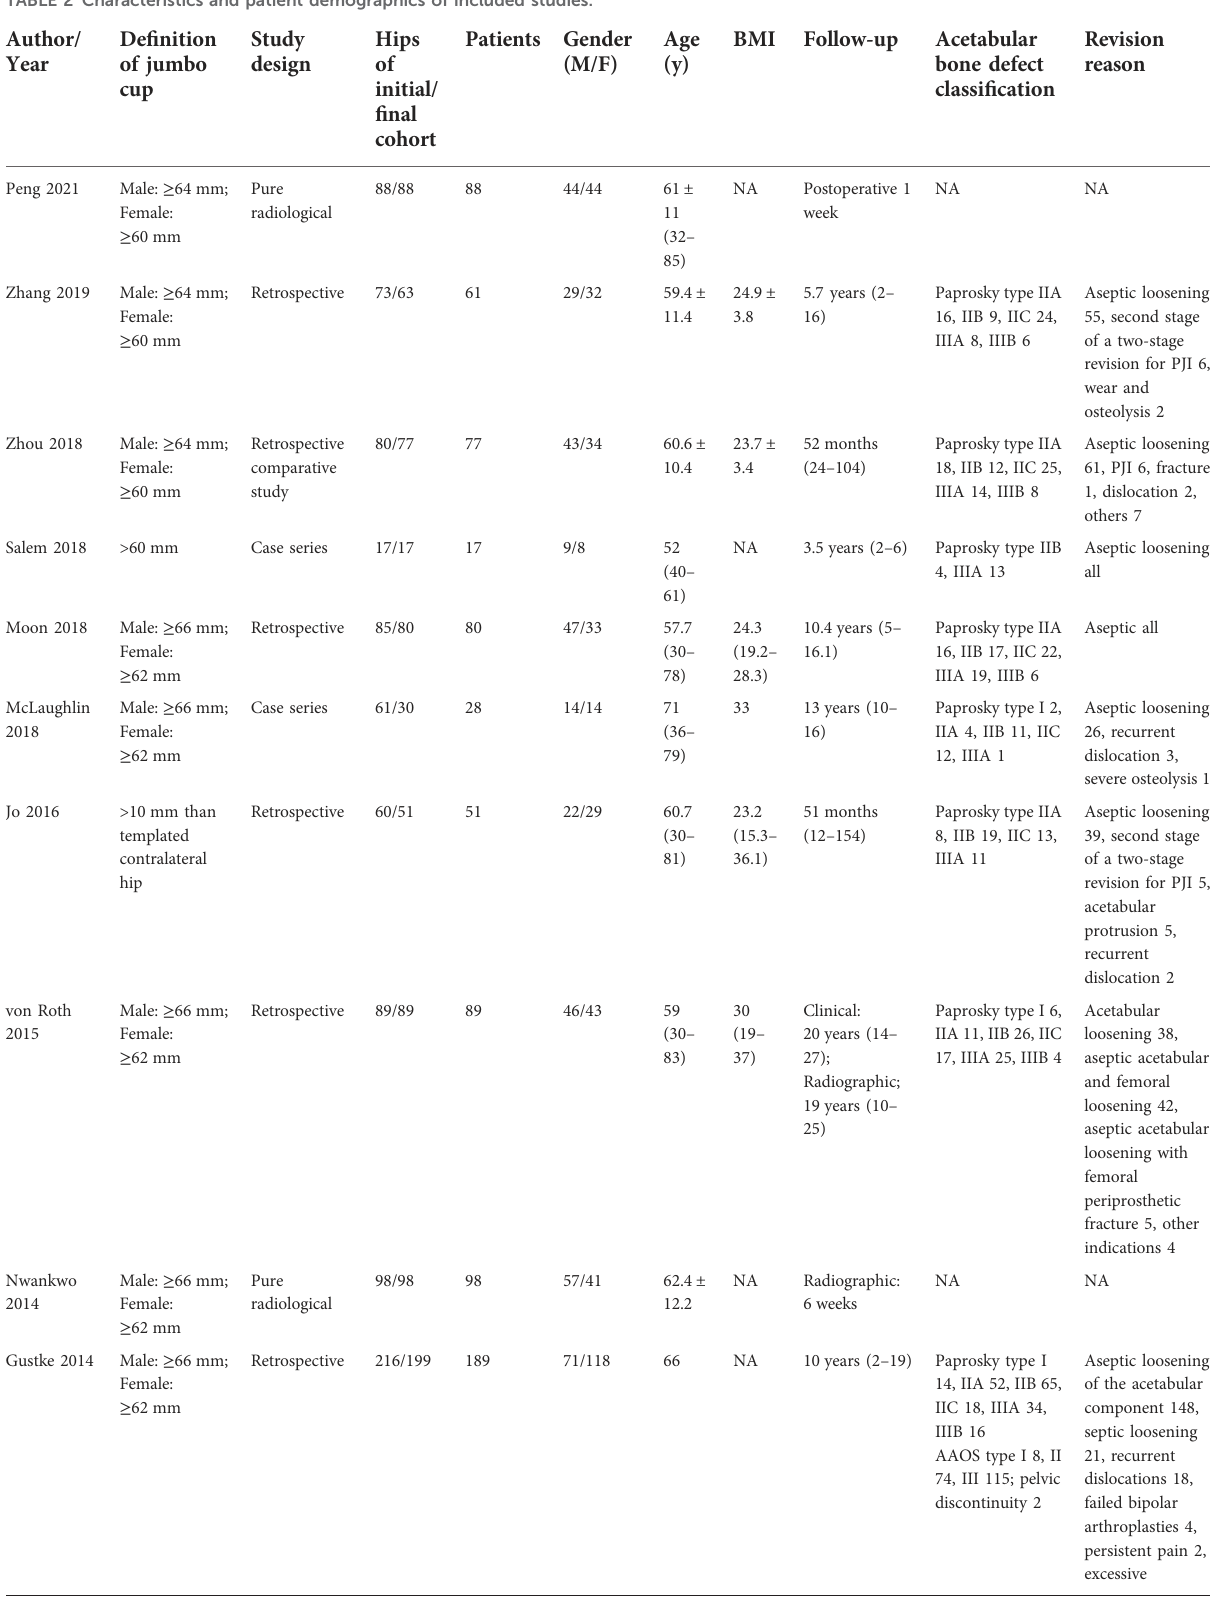
TABLE 2 Characteristics and patient demographics of included